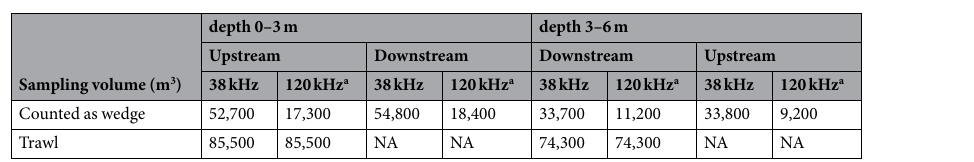
Table 2. Sampling volume of each cruise. a Only night 2 and 3, NA – not